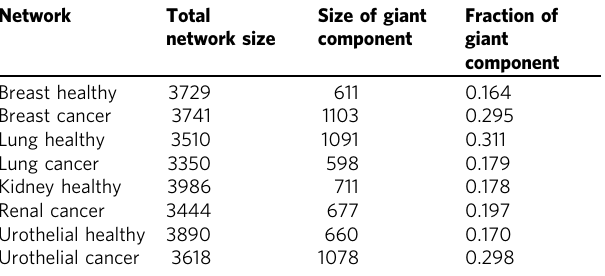
Table 2 Properties of high fl ux correlation networks in healthy and cancer states of human tissues